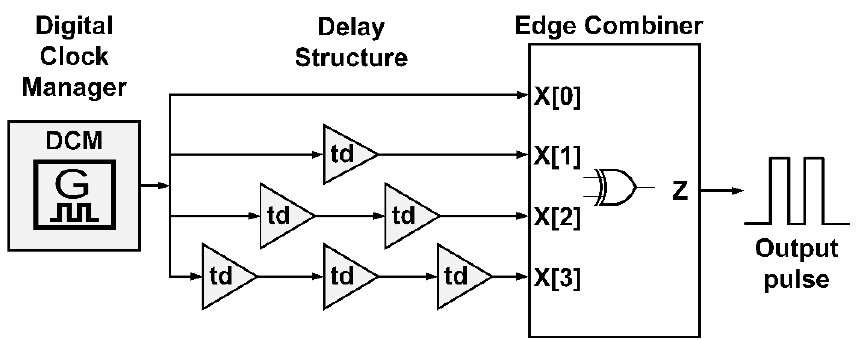
Figure 2. The proposed field programmable gate array (FPGA) scheme for IR-UWB pulse generation.